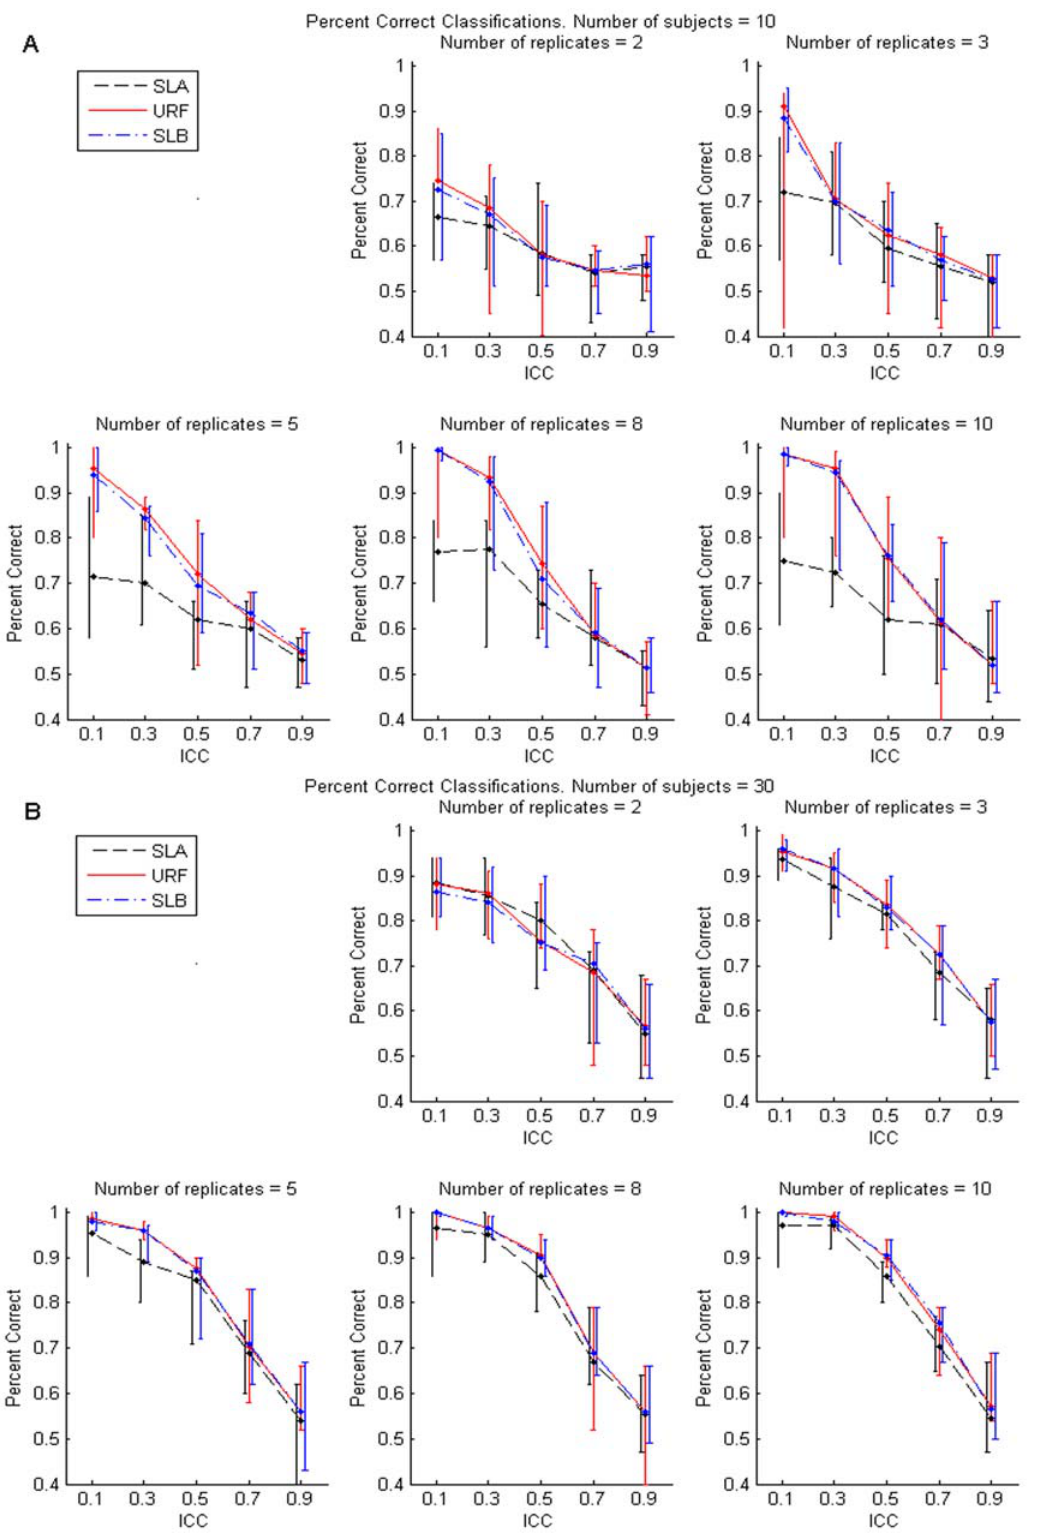
Figure 2. Proportion correct classification. Median and the 5th and 95th percentiles of the proportion correct subject-level classification for 600 simulations (see text) with forests grown on ten subjects (panel A) and 30 subjects (panel B). The median is depicted by a dot, and vertical bars represent the 5th and 95th percentiles. Vertical bars are separated artificially along the x-axis to improve visual representation. Results for SLB and URF forests grown on subject-level bootstrapped data correspond to dot-dashed blue and solid red lines, respectively. The dashed black lines correspond to SLA.